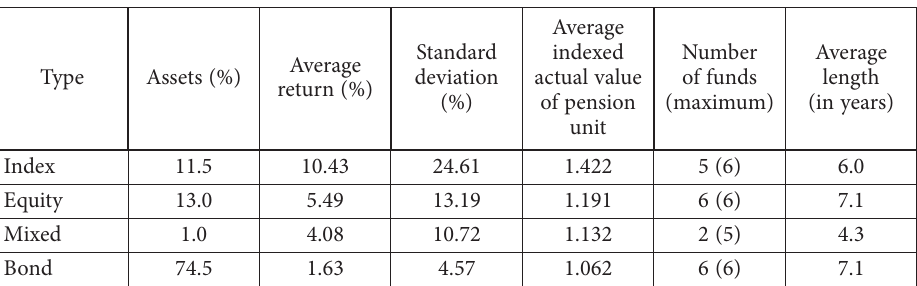
Table 1. Descriptive statistics, final sample of pension funds in